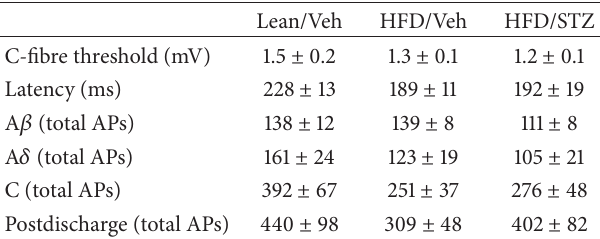
Table 1: Effects of the HFD/STZ model on electrically evoked responses of dorsal horn